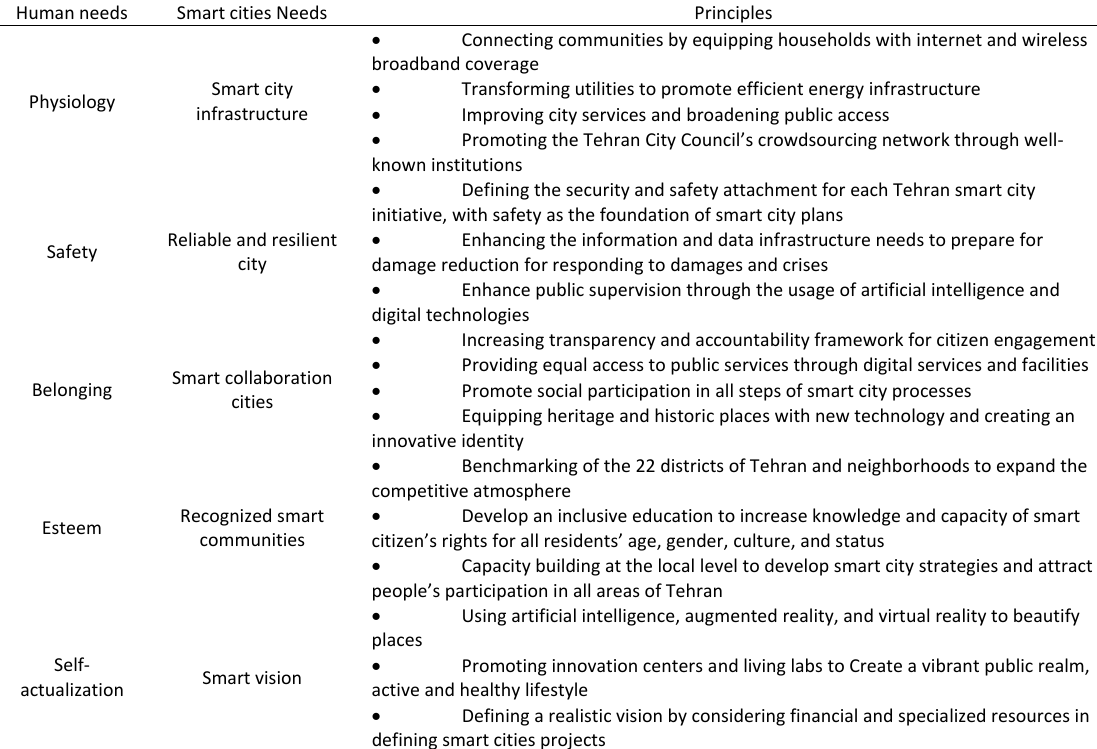
Table 8: Smart city implementation principles for Tehran smart city based on Maslow’s hierarchy of needs